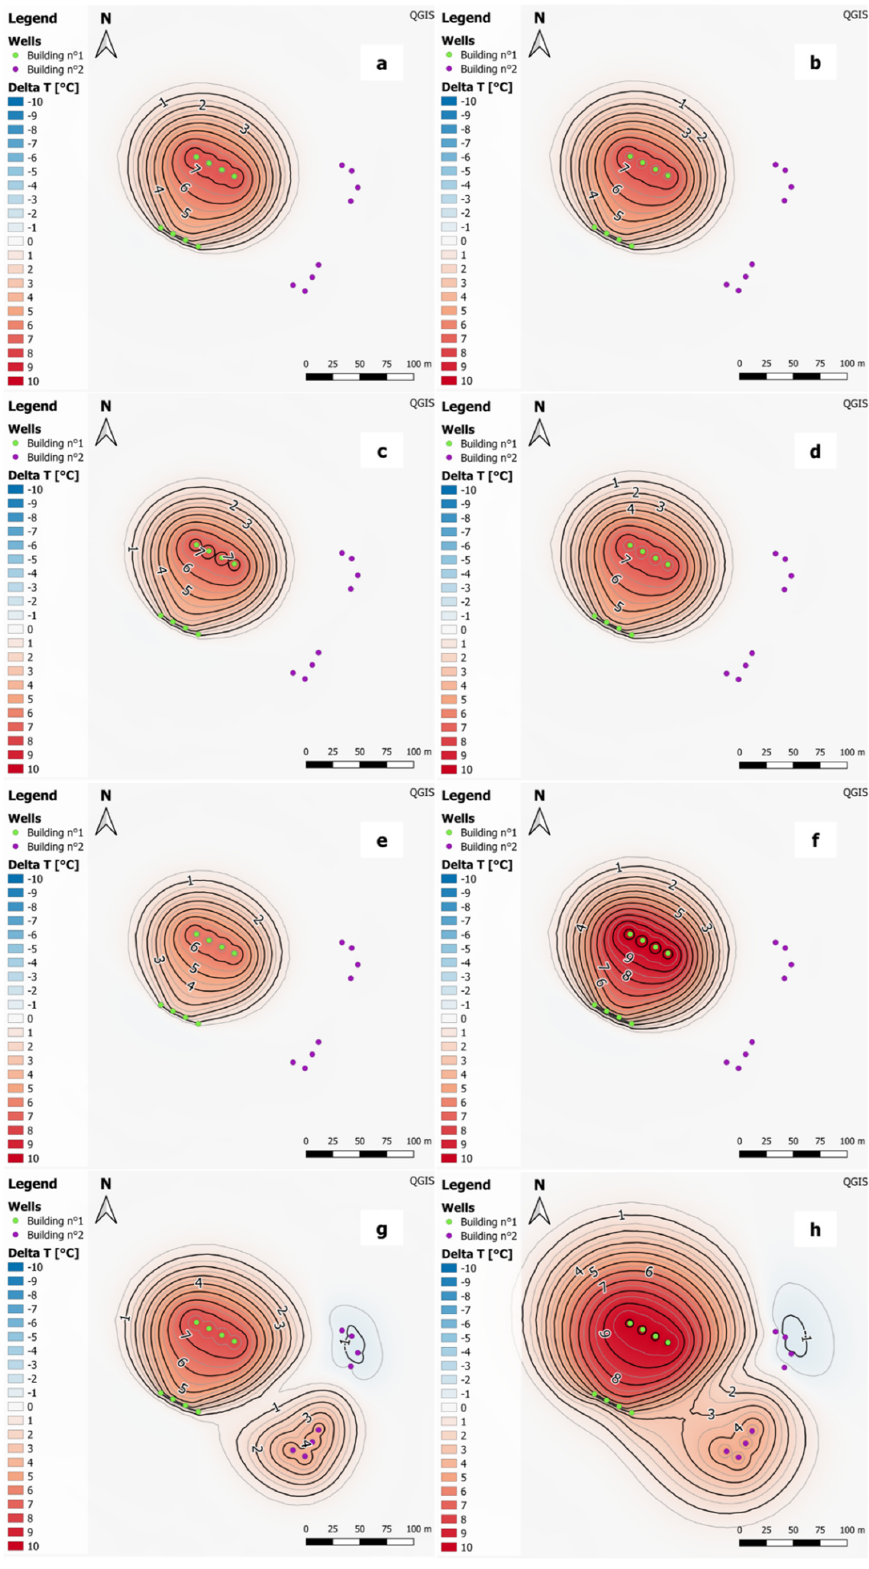
Figure 9. Temperature difference from the initial state (i.e., background T ) at the end of the cooling season in 2019 in ( a ) scenario 1, ( b ) scenario 2, ( c ) scenario 3, ( d ) scenario 4, ( e ) scenario 5, ( f ) scenario 6, ( g ) scenario 7 and ( h ) at the end of the cooling season in 2029 (scenario 8).